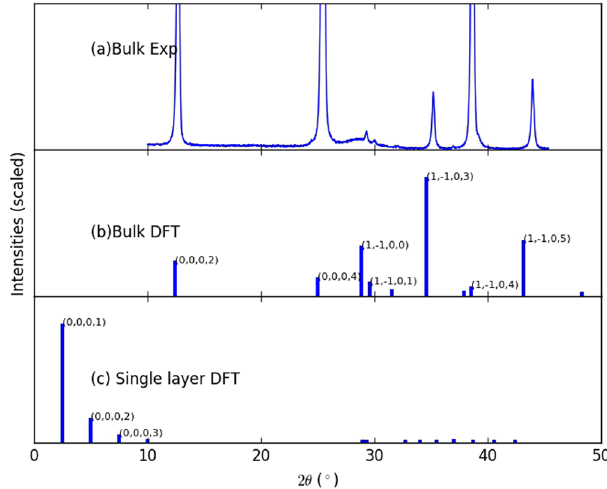
Figure 4. XRD plots for ( a ) bulk 2H-MoTe 2 obtained with experiment, ( b ) bulk 2H-MoTe 2 obtained with DFT using optB88 functional, ( c ) single layer MoTe 2 with DFT using optB88 functional. Some of the important peaks are labelled with corresponding Miller indices. Single layer XRD have significant difference from the bulk